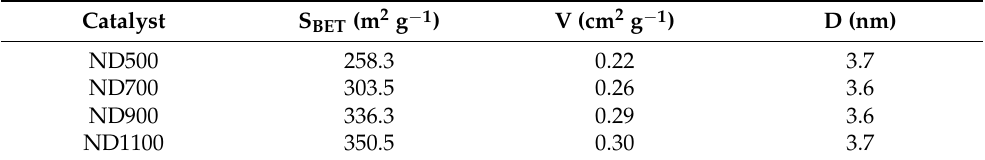
Table 3. BET analysis of ND500, ND700, ND900, and ND1100 catalysts.